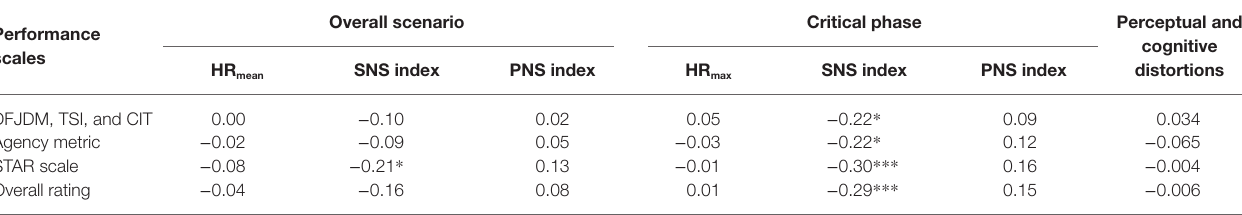
Perceptual and cognitive distortions (n = 121), HR (n = 122), and HRV (n = 116). An independent samples t test was conducted to examine if there were differences in performance between participants with and without HRV data. No significant differences were found (p > 0.05). * Indicates p <